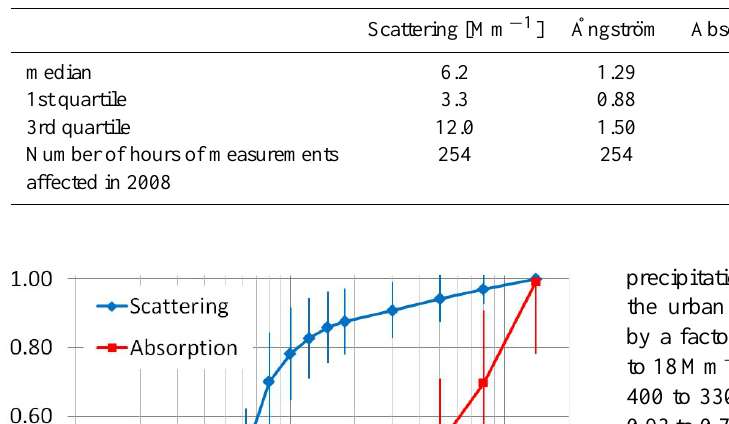
Table 9. Statistics for aerosol particle scattering coefficients (550nm), scattering ˚Angstr¨om exponent, absorption coefficient (637nm), single scattering albedo (637nm) and particle number concentration during episodes of African advection between Feb and May 2008.